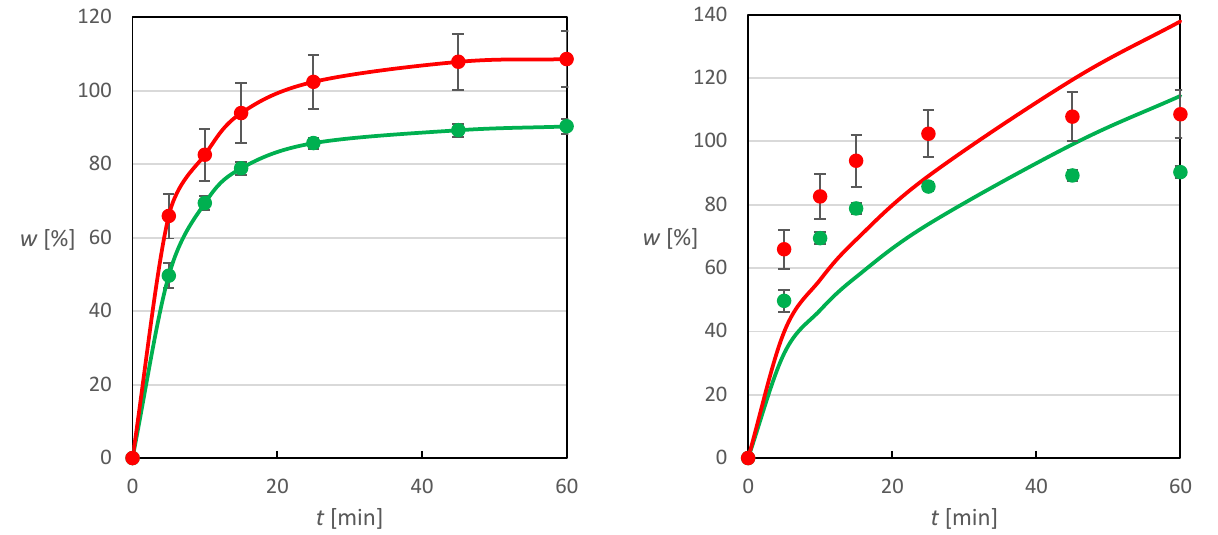
Figure 11. Dissolution profiles of tablets prepared from impregnating MCC granulate (cid:4) compared to